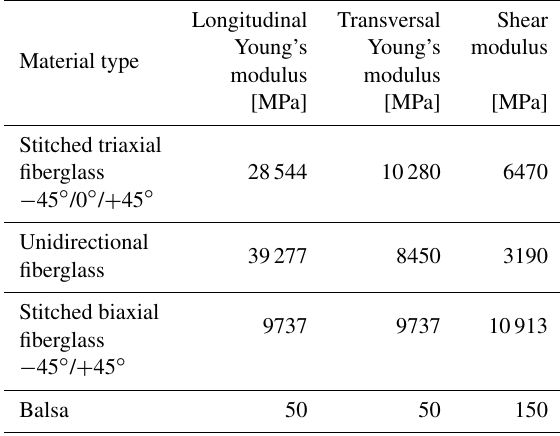
Table 5. Summary of design parameters p g for the holistic opti- mization of the 2.2MW onshore wind